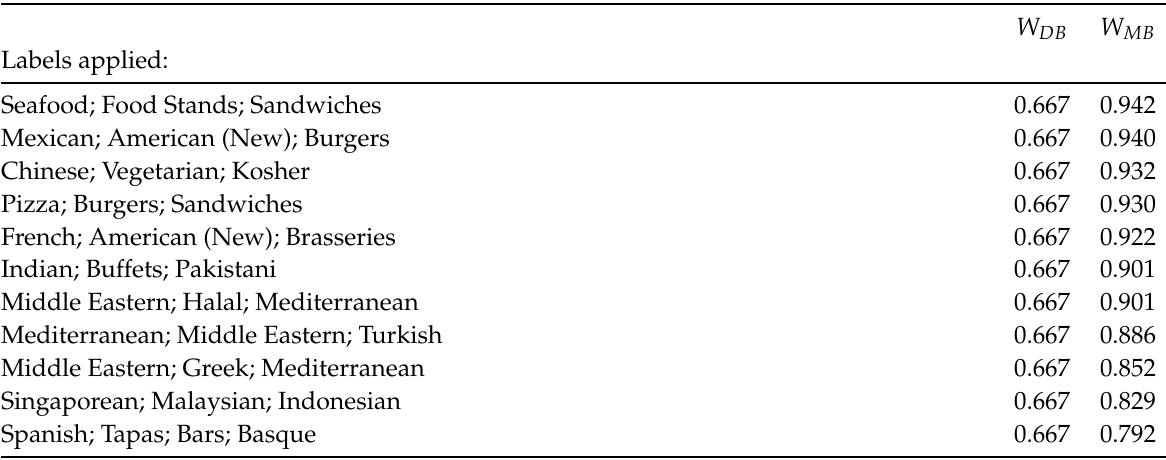
Table 3: Examples of alternative calculations of categorical niche width for restaurants with assignments to three labels using the binary-discrete approach and binary-metric